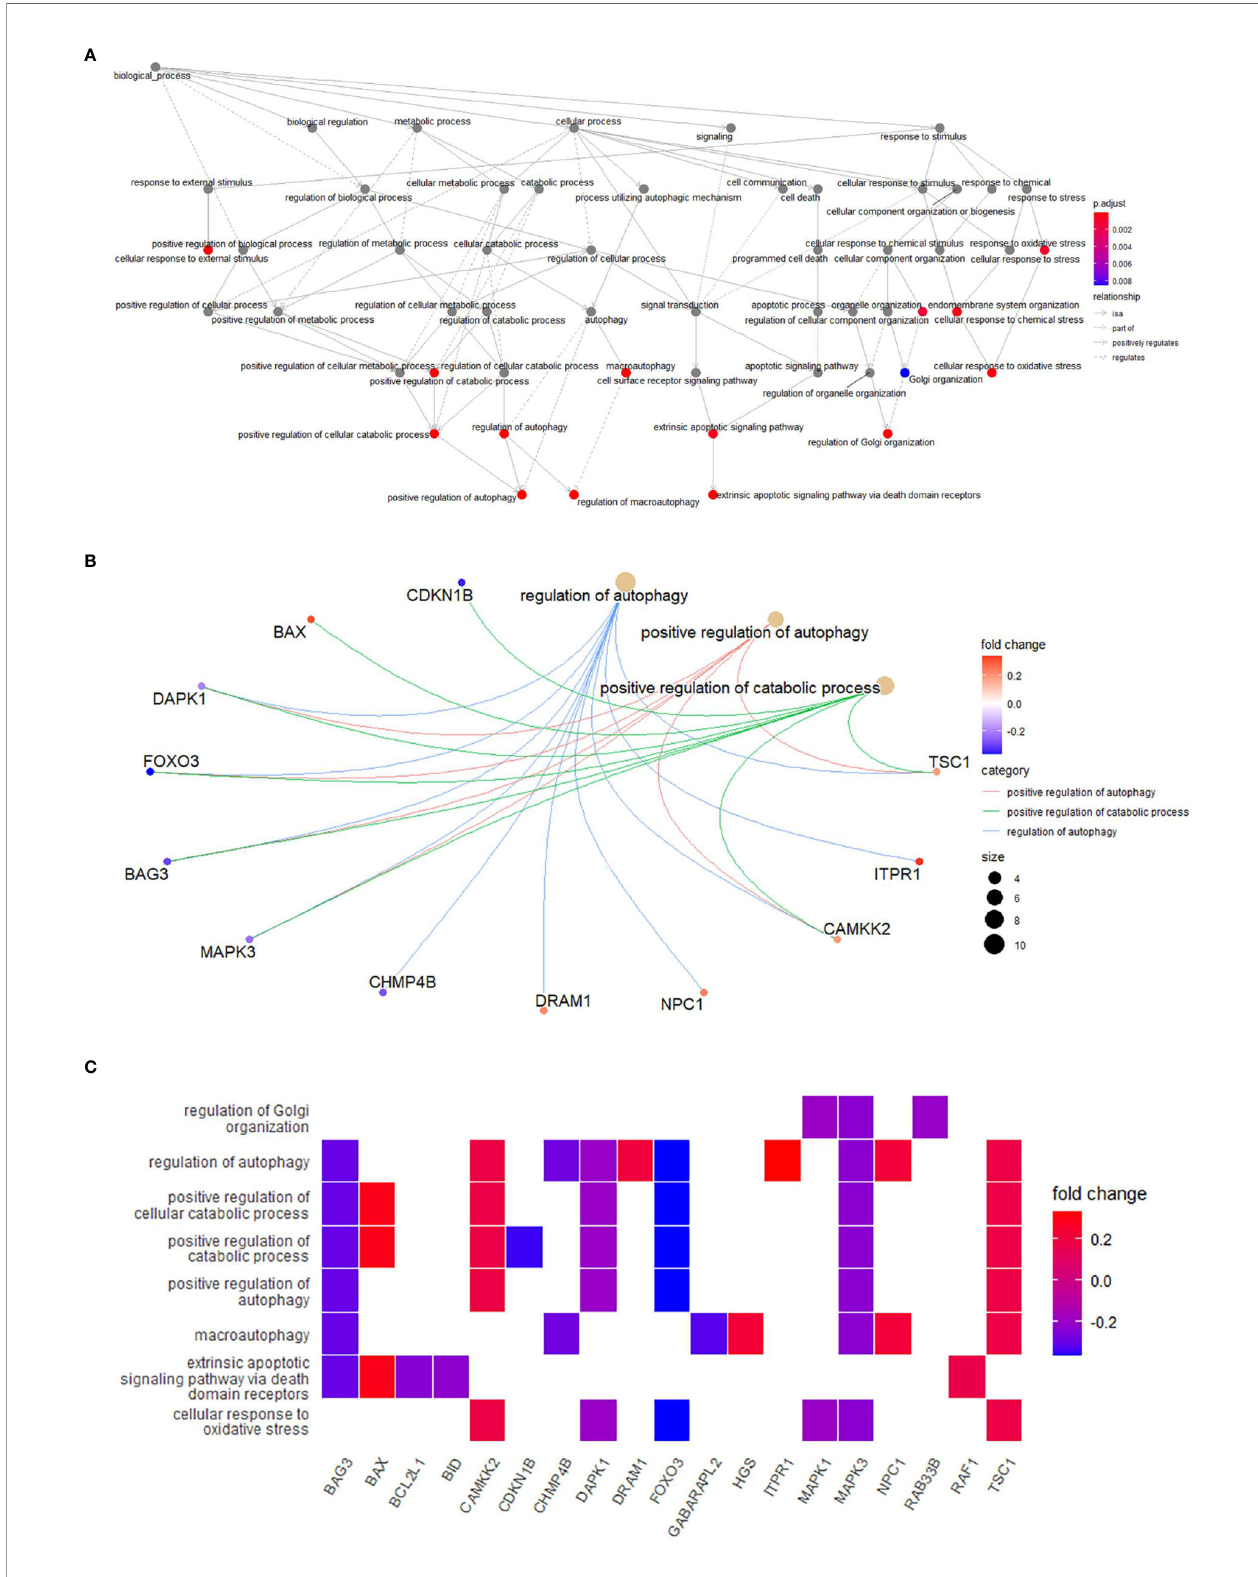
FIGURE 5 | (A) , Relationships between enriched pathways. (B) , Common genes in the most top pathways. (C) , Heatmap-like functional classi fi